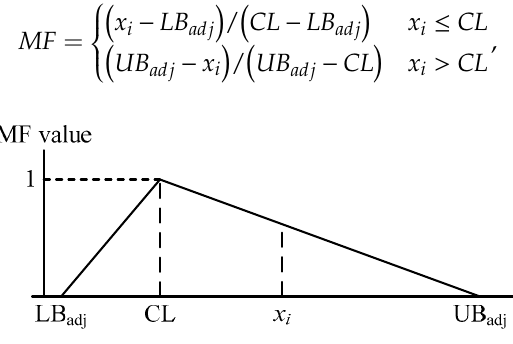
Figure 1. Triangular membership function (MF).